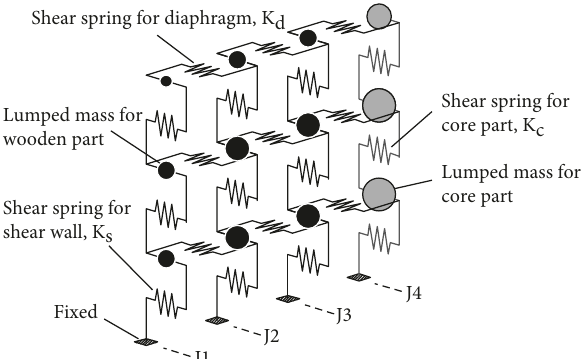
Shear spring for core part, Kc